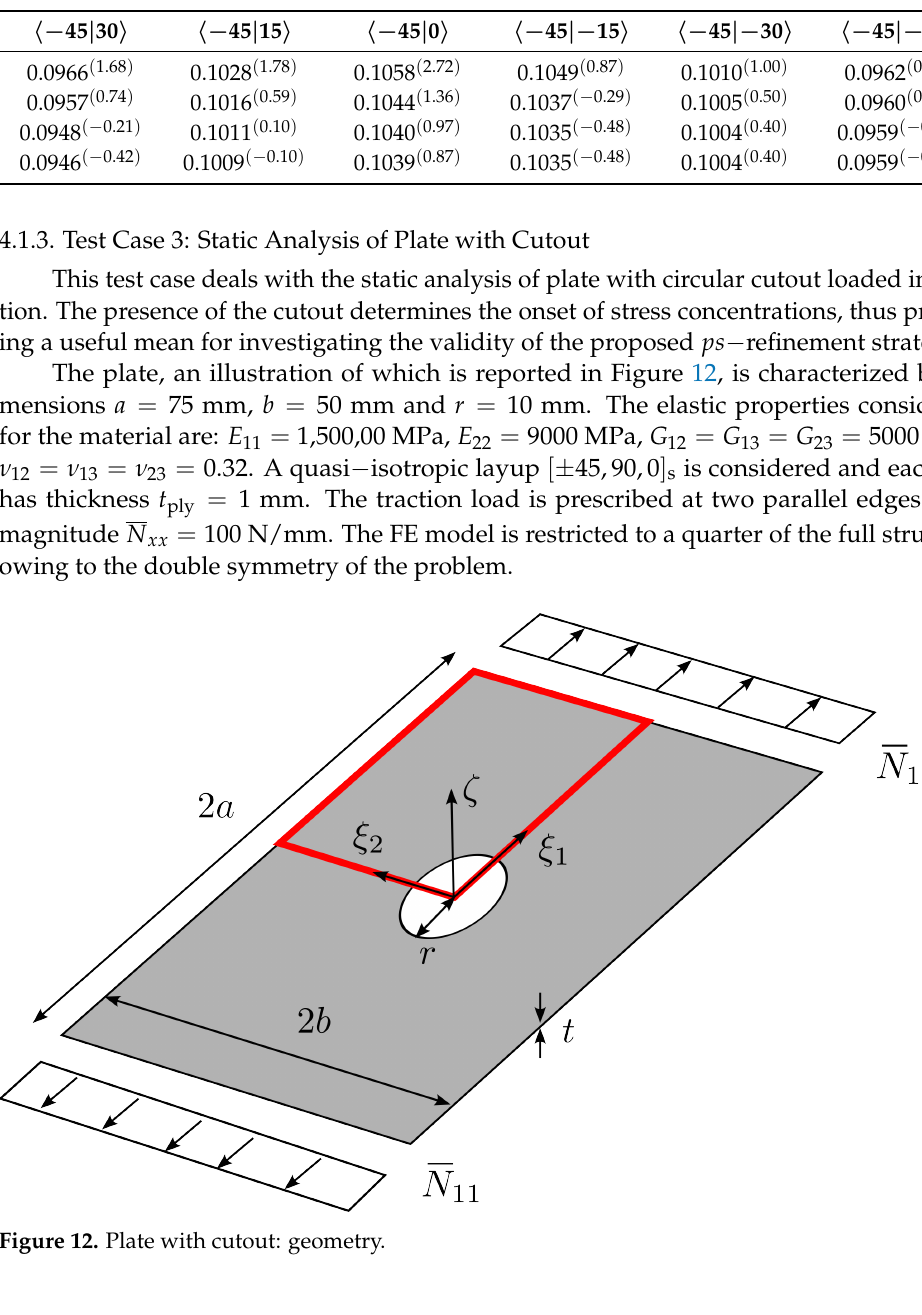
Table 3. Natural frequencies (rad/s) of rectangular plate with different variable stiffness layups. Subscript: percent difference against ref. [50].